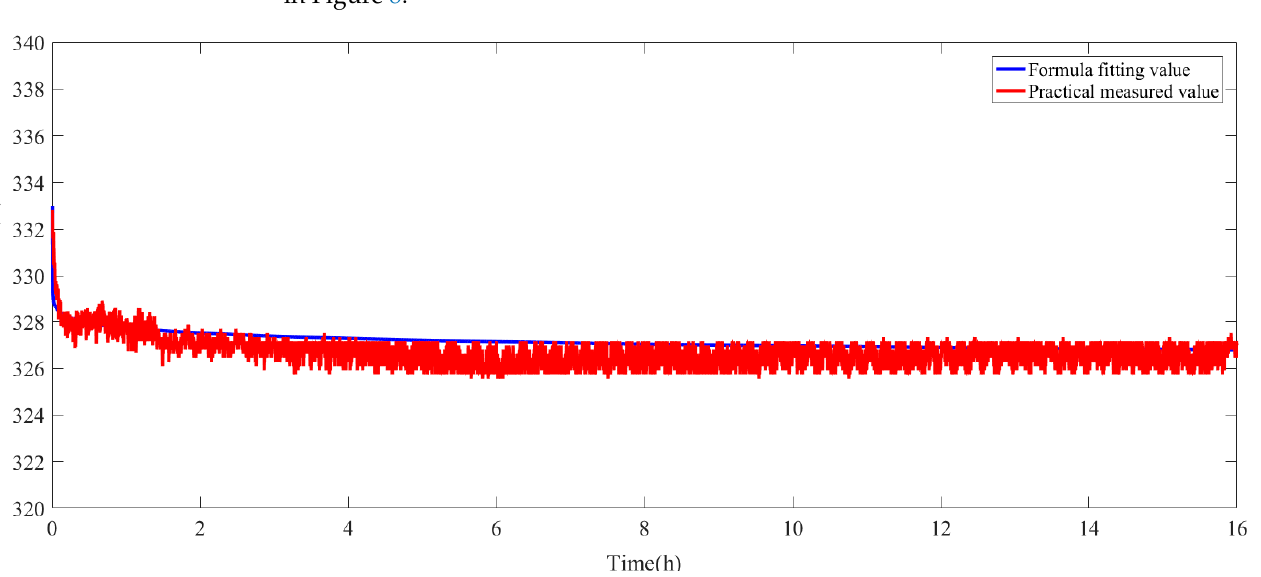
Table 1. Values of B and N corresponding to different elastic forces.